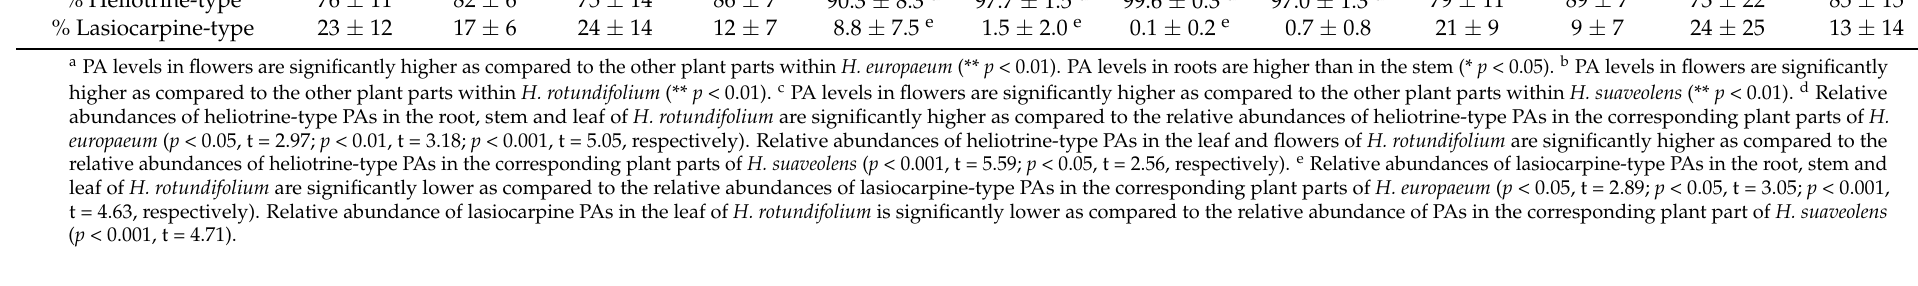
Flower Root Stem Leaf Flower